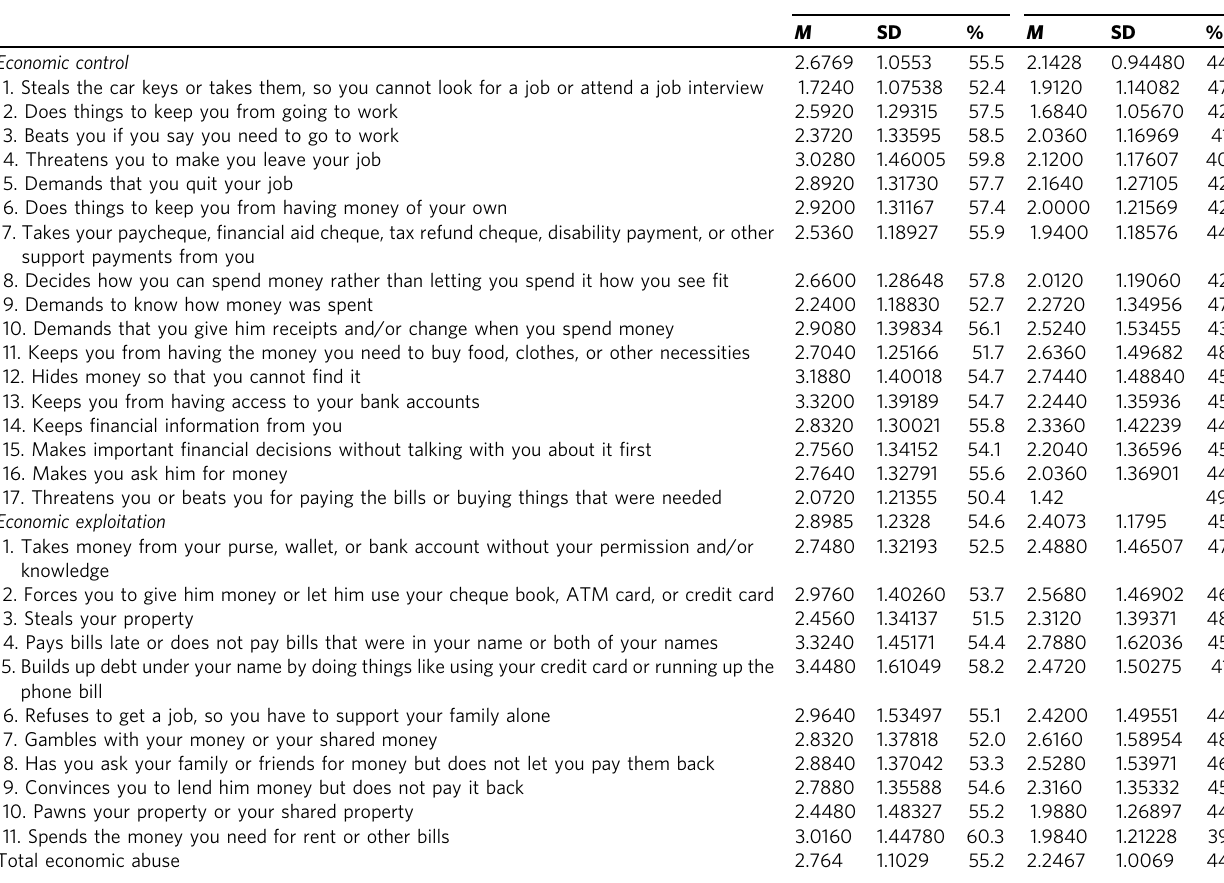
Table 2 Working married women ’ s responses to the Scale of Economic Abuse (SEA). Items